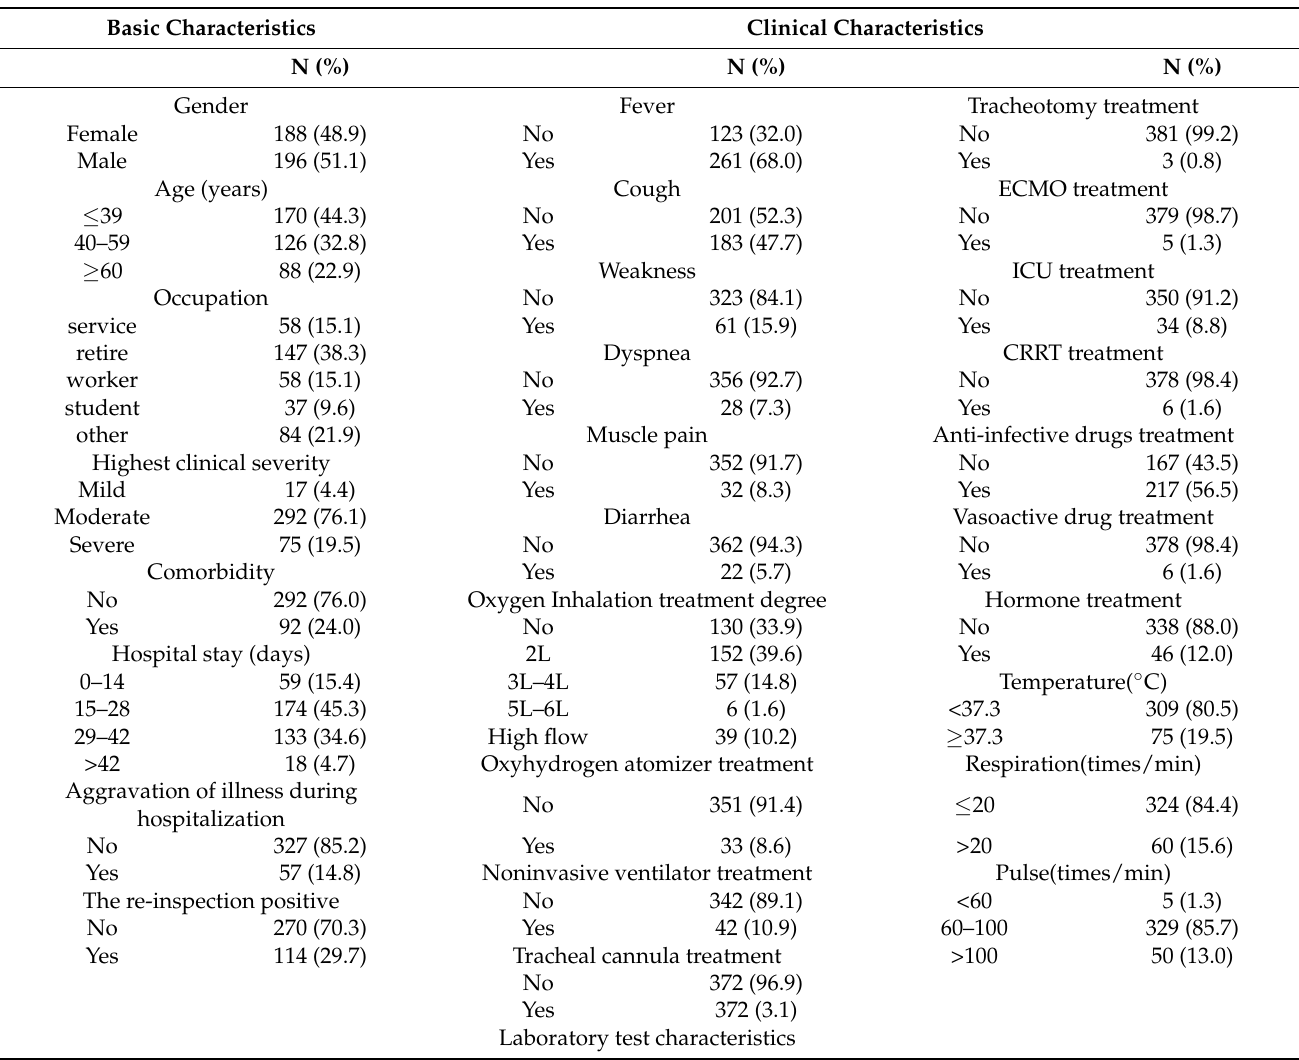
Table 1. General characteristics of 384 COVID-19 cases (n =